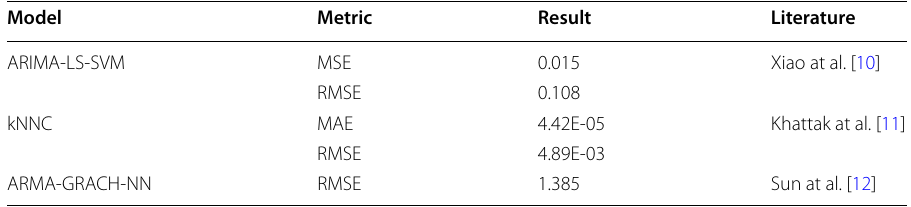
Table 1 Relevant studies using machine learning